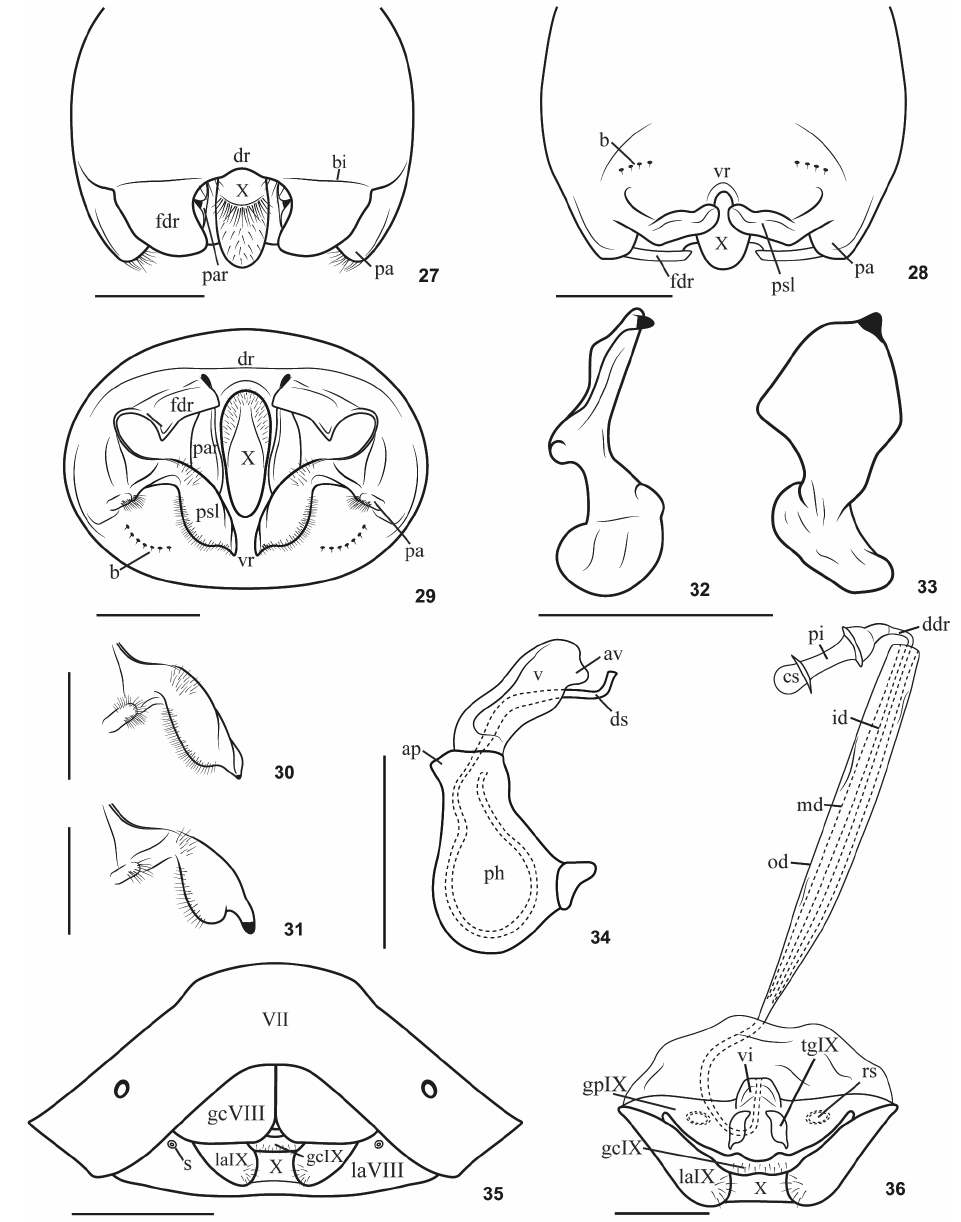
Figures 27–36. Lineostethus marginellus : (27–29) male pygophore, dorsal, ventral and posterior views respectively; (30–31) variations on the shape of the projections of superior layer of ventral rim; (32–33) left paramere, dorsal and lateral views; (34) phallus, lateral view; (35) female genital plates; (36) female receptaculum seminis. Abbreviations: ap, ventral apical projection of phallotheca; av, apical margin of vesica; b, bristles; bi, basal impression of foliaceous expansions; cs, capsula seminalis; ddr, distal ductus receptaculi; dr, dorsal rim; ds, ductus seminis distalis; fdr, foliaceous expansions of dorsal rim; gcVIII, gonocoxites VIII; gcIX, gonocoxites IX; gpVIII, gonapophyses VIII; gpIX, gonapophyses IX; id, internal duct of vesicular area; la8, laterotergites VIII; la9, laterotergites IX; md, median duct of vesicular area; od, outer duct of vesicular area; pa, posterolateral angle; par, paramere; ph, phallotheca; pi, pars intermedialis; psl, projection of superior layer of ventral rim; rs, ring sclerites; s, spiracle; tgIX, thickening of gonapophyses IX; v, vesica; vi, thickening of vaginal intima; vr, ventral rim; VII, urosternite VII; X, segment X. Scale bars: 27–33, 35 = 1 mm; 34, 36 = 0.5 mm. ZOOLOGIA 35: e21232 | DOI: 10.3897/zoologia.35.e21232 | November 1, 2018 11 /